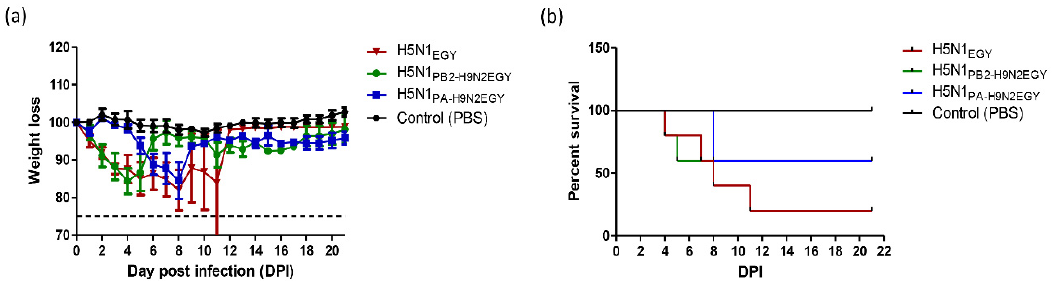
Figure 5. Pathogenicity of H5N1 EGY and reassortants H5N1 PB2-H9N2EGY and H5N1 PA-H9N2EGY in female BALB / c mice. Mice were infected with 10 5 PFU of each virus in 100 μ l phosphate-buffered saline (PBS). The morbidity rate and the mortality rate as demonstrated by weight loss of body ( a ) and the survival rate ( b ), respectively, were monitored for 14 dpi. Mice judged moribund (body weight loss > 25%) were euthanized.